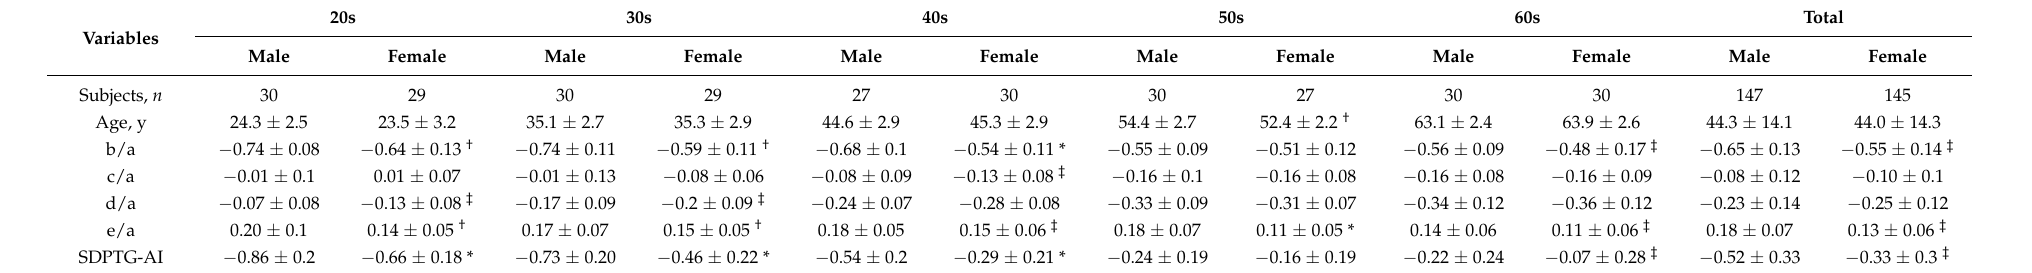
Data are provided as number of participants or mean ± standard deviation (SD). p -values were derived using the independent t -test considering sex differences (males vs. females) in each age group. * p < 0.05, † p < 0.01, ‡ p < 0.001. b/a, ratio of the height of b wave to that of a wave of SDPTG; c/a, ratio of the height of c wave to that of a wave of SDPTG; d/a, ratio of the height of d wave to that of a wave of SDPTG; e/a, ratio of the height of e wave to that of a wave of SDPTG; SDPTG-AI, SDPTG aging index calculated as (b-c-d-e)/a. Age was divided into groups: 20s (19–29 years), 30s (30–39 years), 40s (40–49 years), 50s (50–59 years), and 60s (60–69